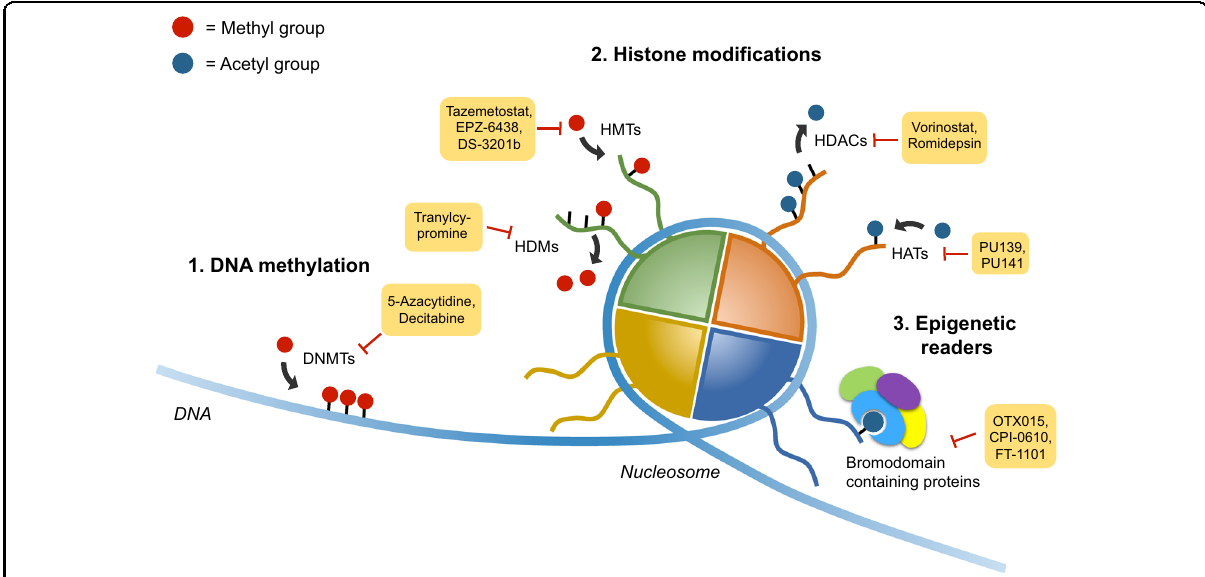
Fig. 1 Main epigenetic targets. Current inhibitors act on three different epigenetic levels: DNA methylation, histone methylation or acetylation, and chromatin reading. This scheme highlights the most promising drugs that target proteins involved in these processes with a subset already under clinical trials or even approved for treatment of certain